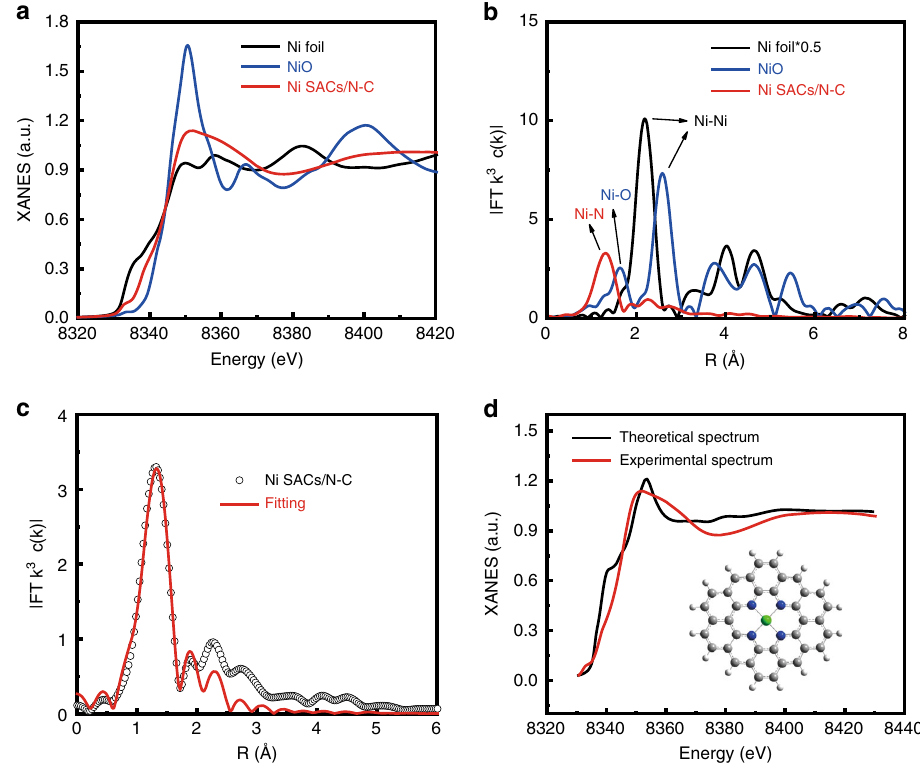
Fig. 2 Structural analysis of Ni SACs/N-C. a XANES spectra of Ni SACs/N-C. b Fourier transforms of the EXAFS spectra for the Ni K-edge of Ni SACs/N- C, NiO and Ni foil. c The corresponding EXAFS fi tting curves of the Ni SACs/N-C nanospheres at R space. d Comparison between the XANES experimental spectrum for graphene models of Ni SACs/N-C at Ni K edge (red curve) and the theoretical spectra calculated with the depicted structures (black curve). Inset, proposed Ni-N 4